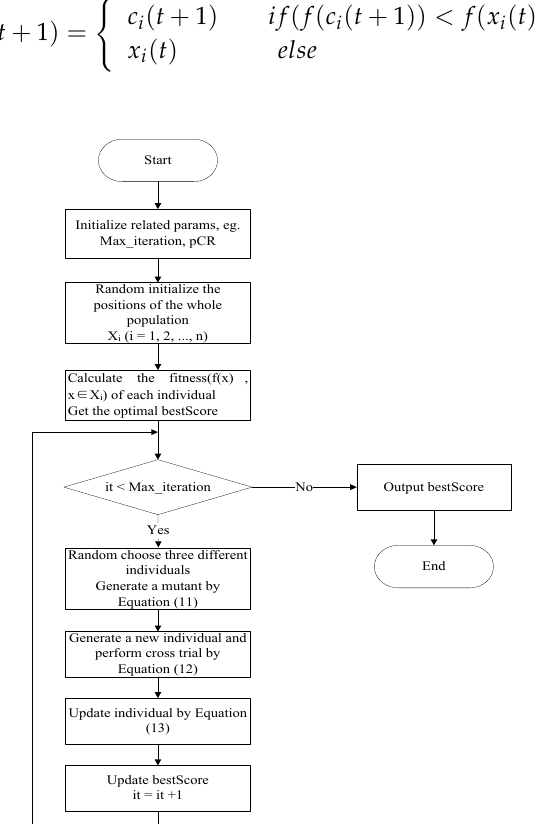
Figure 2. The complete flow chart of